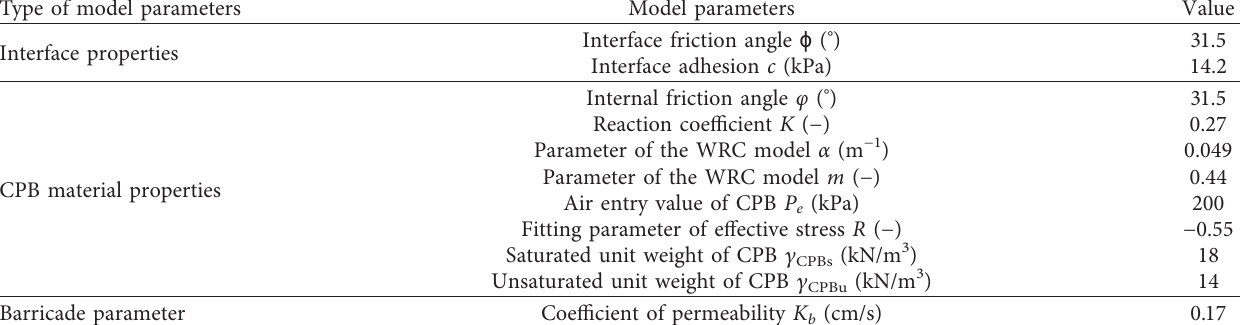
Symbol “-” indicates dimensionless unit.